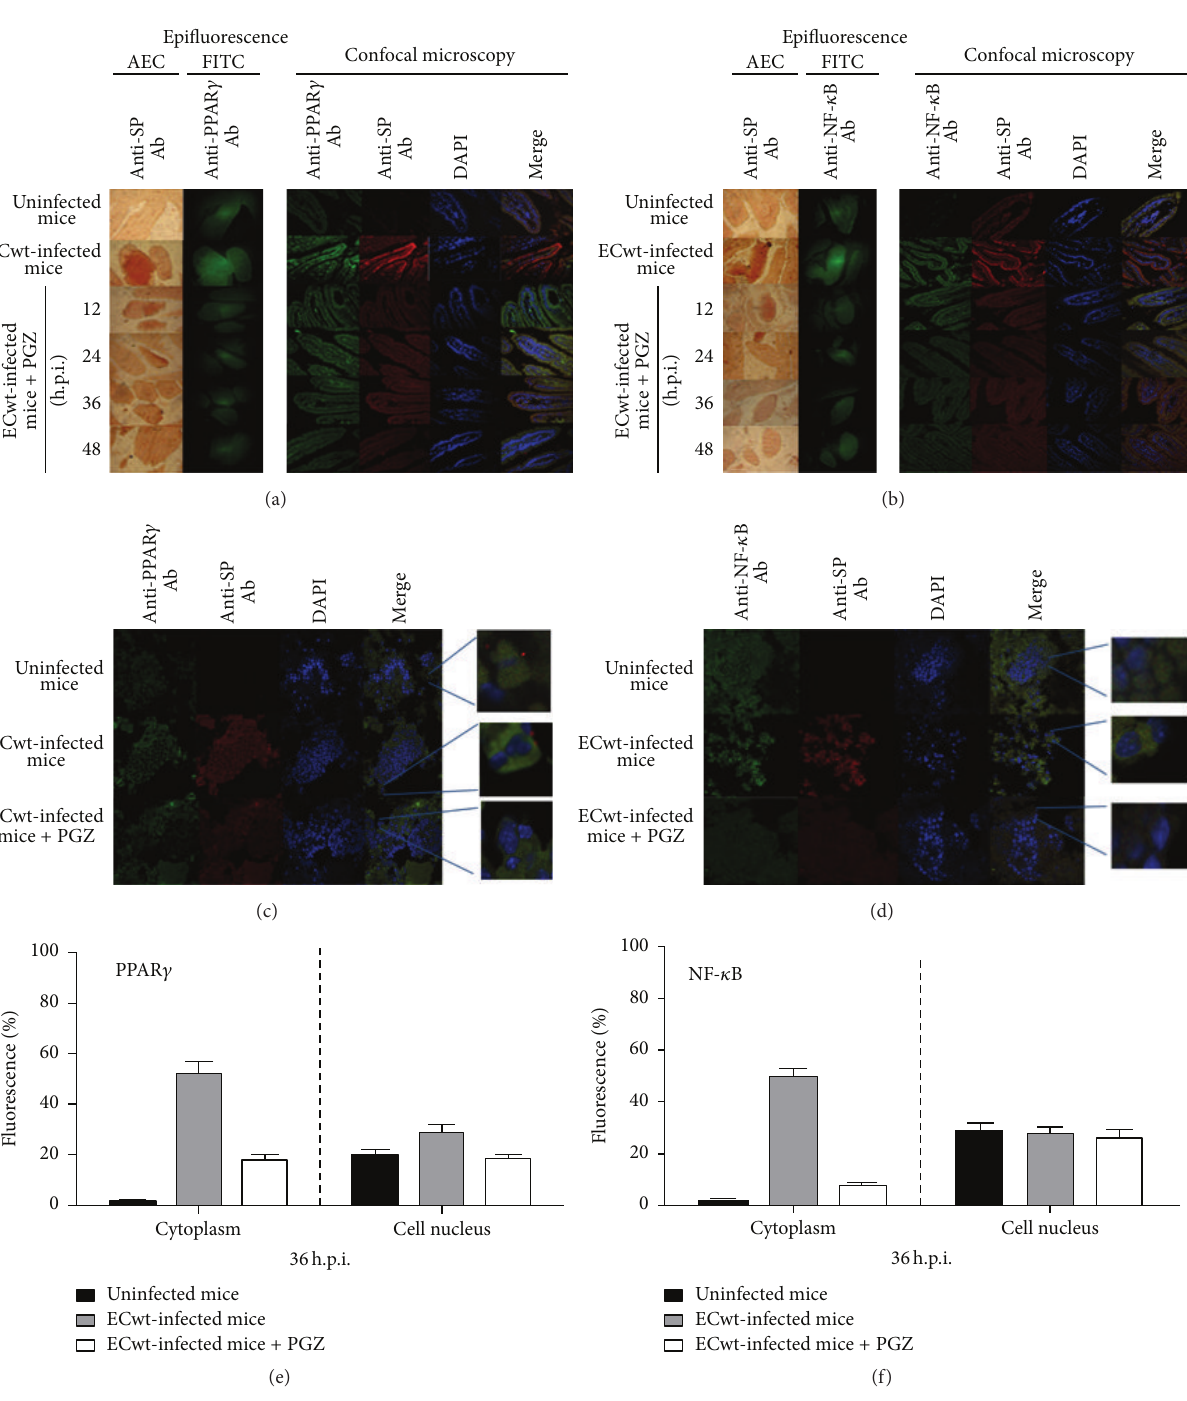
Figure5:Immunochemistry,immunofluorescence,andconfocalmicroscopyanalysesofPPAR 𝛾 andNF- 𝜅 BinvilluscellsfromECwt-infected micetreatedwithPGZ.(a)HistologicalcrosssectionsofduodenalvillifromECwt-infectedmicethathadbeentreatedwithPGZwereanalyzed by immunocytochemistry for the presence of ECwt SP (EAC) or epifluorescence for the presence of PPAR 𝛾 (FITC). Histological cross sections were observed using confocal microscopy for the identification of PPAR 𝛾 (green) and rotavirus SP (red). Nuclei were counterstained with DAPI (blue). Representative photographs are shown. (b) Histological cross sections analyzed for the presence of NF- 𝜅 B and rotavirus SP as indicated in (a). (c) Villi isolated from ECwt-infected and noninfected mice that have been treated or not with PGZ were processed and analyzed at 36h.p.i. for the subcellular location of PPAR 𝛾 and ECwt SP using confocal microscopy. Representative micrographs are shown. (d) Villi isolated from ECwt-infected or noninfected mice were treated or not as described in (c), except that they were analyzed for the subcellular location of NF- 𝜅 B and ECwt SP. Representative micrographs are shown. (e) Villi from ECwt-infected or noninfected mice ( 𝑛 = 3 per experiment) that had been treated or not with PGZ were subjected to confocal analysis for the quantification of subcellular location (nucleus or cytoplasm) of PPAR 𝛾 . (f) Villi from ECwt-infected or noninfected mice were treated as described in (e), except that they were analyzed for the quantification of subcellular location (nucleus or cytoplasm) of NF- 𝜅 B. Data are shown as mean ± SD from three independent experiments performed in